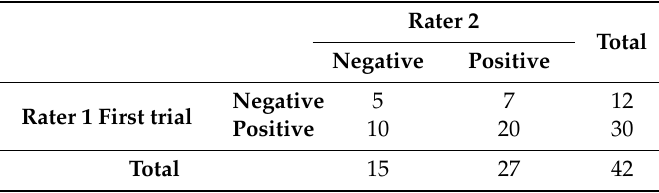
Table 3. Two by two contingency table for inter-rater agreement.